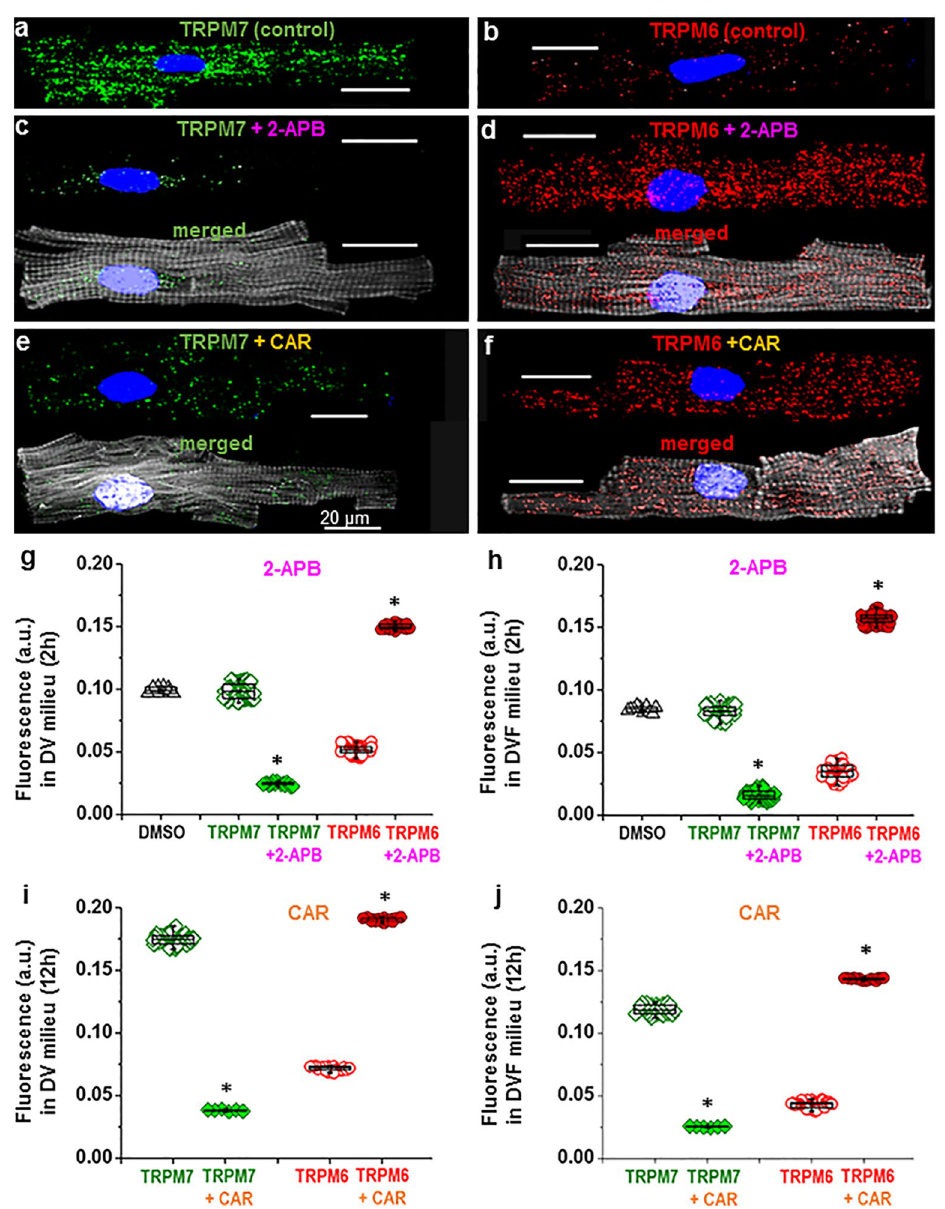
influence of the solvent, DMSO, at 500 μmol/L (triangles) but opposite change with 2-APB and CAR on TRPM7 vs. TRPM6, i.e. decrease of the immunofluorescence level of TRPM7 but increase of the TRPM6 fluorescence level. * P < 0.001 drug vs. no drug. Other notations are the same as in Fig.